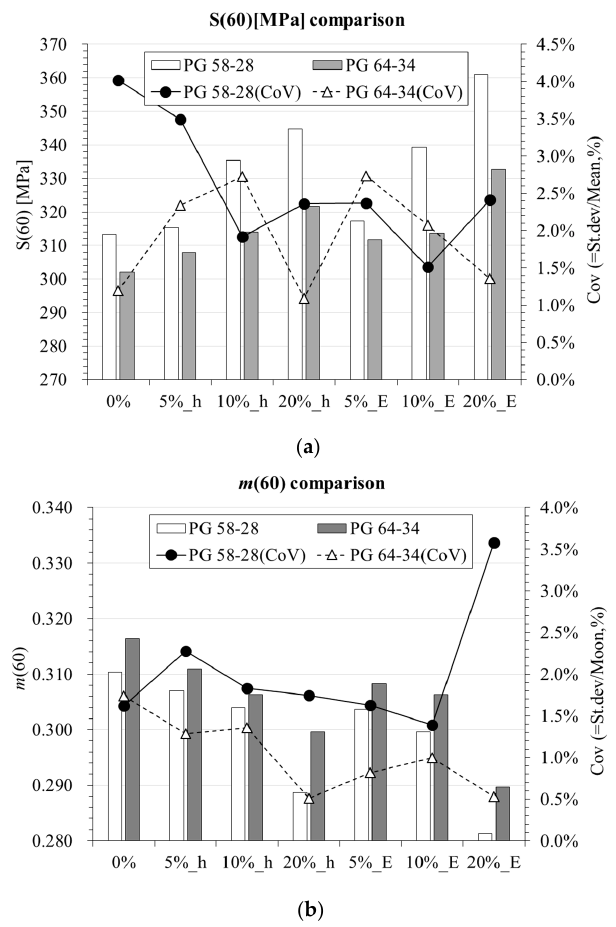
Figure 3. BBR results comparison. ( a ) S (60) [MPa] comparison; ( b ) m (60) comparison.